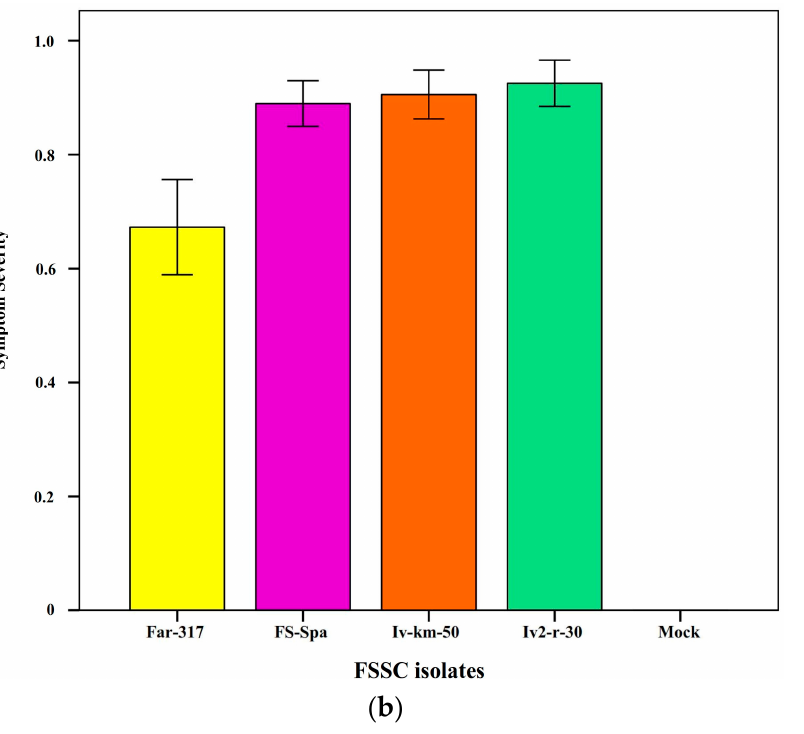
Figure 2. Results of pathogenicity assays of four isolates of diverse FSSC species on different cucurbits. The FSSC species tested included F. keratoplasticum (isolate Iv-km-50), F. falciforme (isolate Iv2-r-30), F. vanettenii (isolate Far-317), and FSSC 5 (isolate FS-Spa). Nine plants of each cucurbit species or variety were inoculated per fungal isolate, and the same number of plants was mock-inoculated with water. Symptom severity was evaluated 30 days after inoculation. ( a ) Symptom severity induced by each Fusarium isolate on 11 diverse cucurbits (means of nine values ± SE). ( b ) Values of symptoms severity induced by each Fusarium isolate on 11 diverse cucurbits were pooled together to compare the virulence of isolates (means of 99 values ± SE).